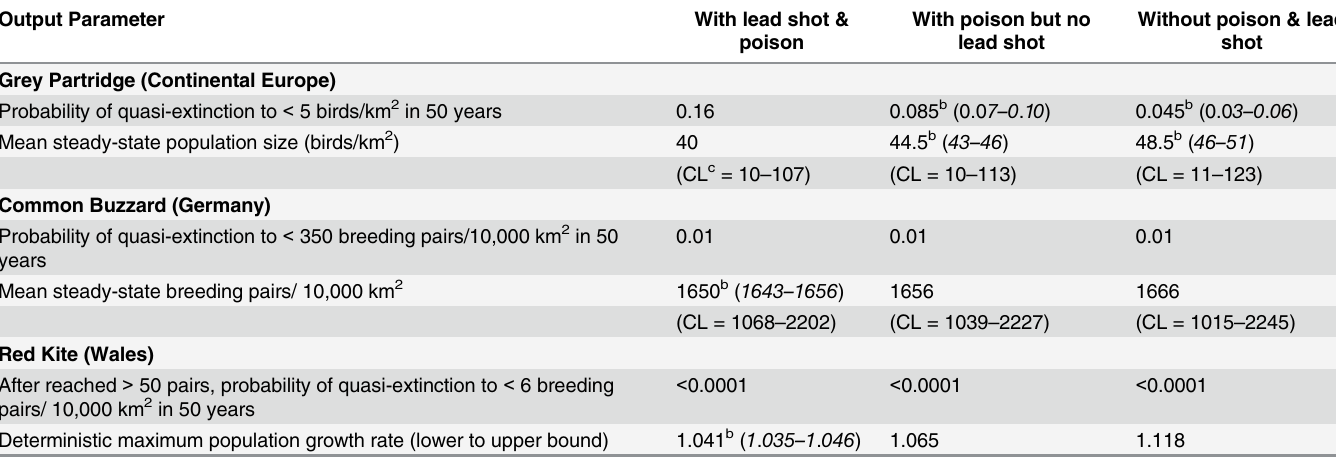
Table 2. Model outputs for baseline a , lead shot, and poison-ingestion mortality scenarios. Output Parameter